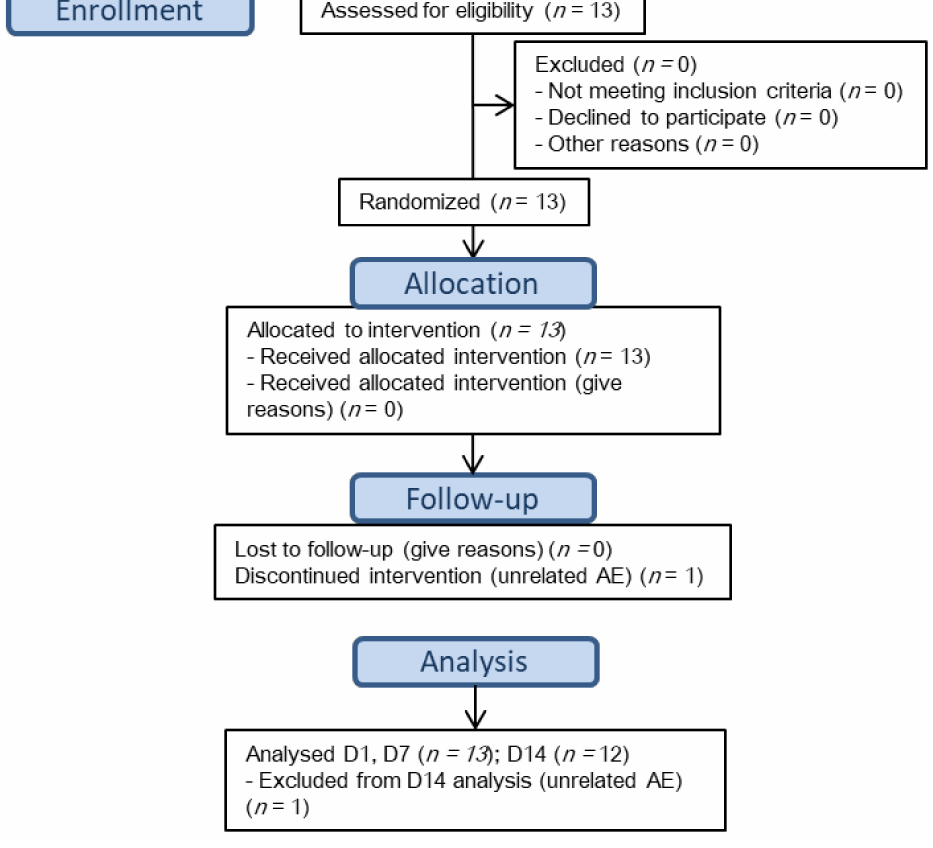
Figure 2. Patient Flow